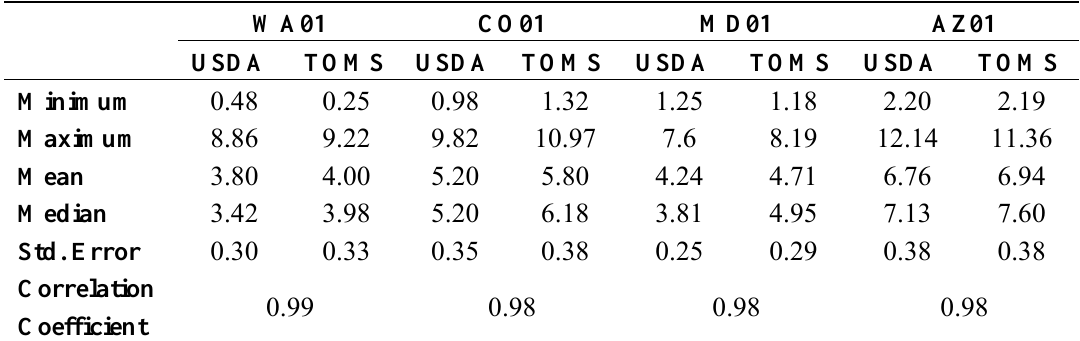
Table 1. Monthly statistical analysis of UVI data collected by four ground-based USDA stations and the TOMS Data (1999–2005,